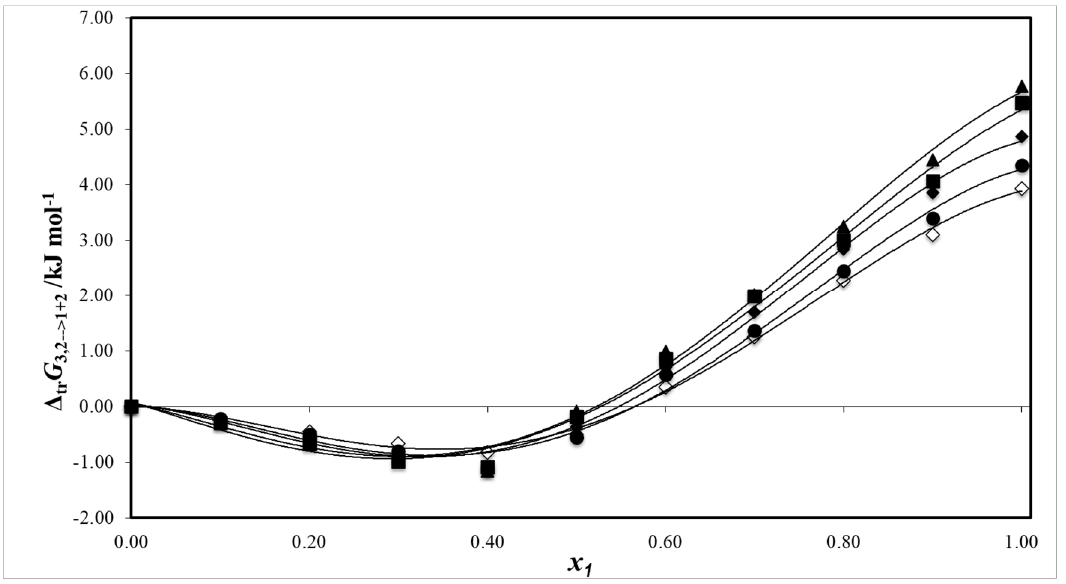
Figure 7. Gibbs energy of transfer of amygdalin (3) from pure water (2) to {ethanol (1) + water (2)} mixtures at several temperatures: □ : 293.15 K; ● : 298.15 K; ♦ : 303.15 K; ■ : 308.15 K; and ▲ : 313.15 K.